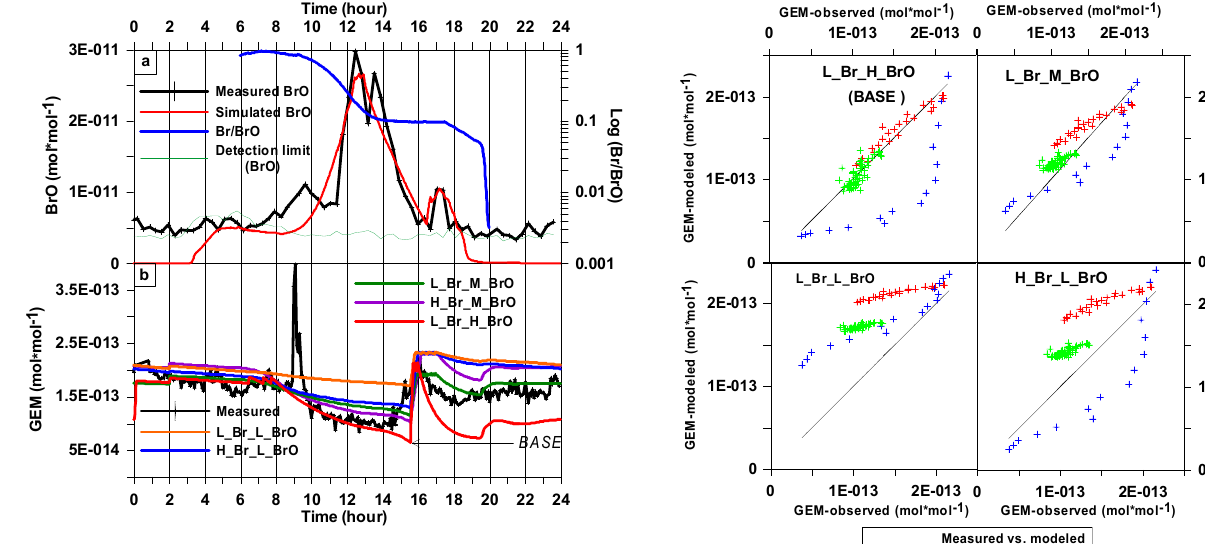
Fig. 3. Simulated and measured diurnal profiles of GEM and BrO. (a) Measured and simulated diurnal profiles of BrO and simulated Figure 3. Simulated and measured diurnal profiles of GEM and BrO. (a) Measured diurnal profile of [Br]/[BrO] for Julian day 201. (b) Different com- and simulated diurnal profiles of BrO and simulated diurnal profile of [Br]/[BrO] for binations of values for k GEM + BrO and k GEM + Br were used to eval- Julian day 201. (b) Different combinations of values for k GEM+BrO and k GEM+Br were uate the simulated GEM diurnal profiles. Figure 4. Comparison between measured (x-axis) and simulated (y-axis) GEM mixing used to evaluate the simulated GEM diurnal profiles.